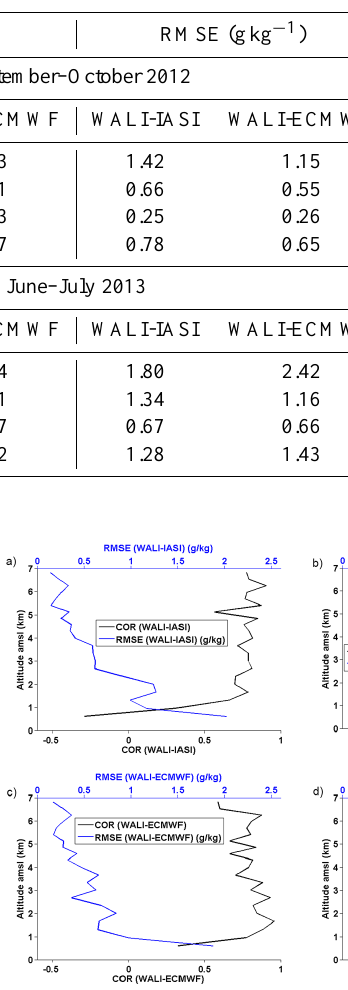
Table 4. Scores on the WVMR retrieval for the inter-comparisons between WALI and IASI (WALI-IASI), and WALI and ECMWF (WALI- ECMWF). The results are given for different atmospheric layers in terms of COR and RMSE for the two time periods.